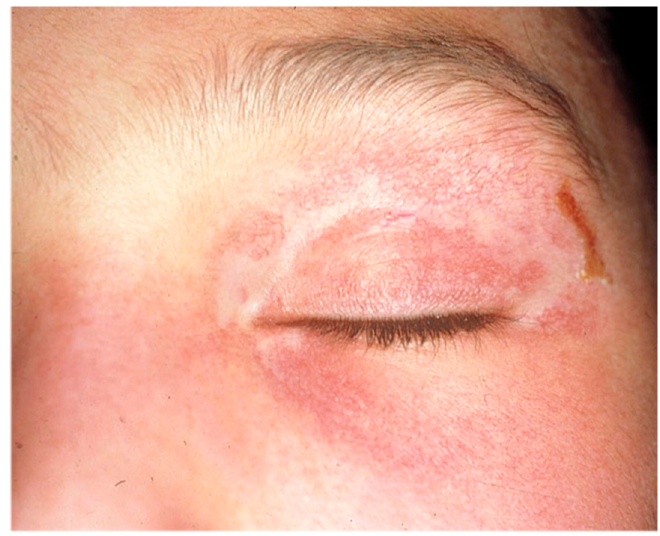
Figure 2. Appearance of the heliotrope rash coinciding with the onset of digestive symptoms in case 1 .